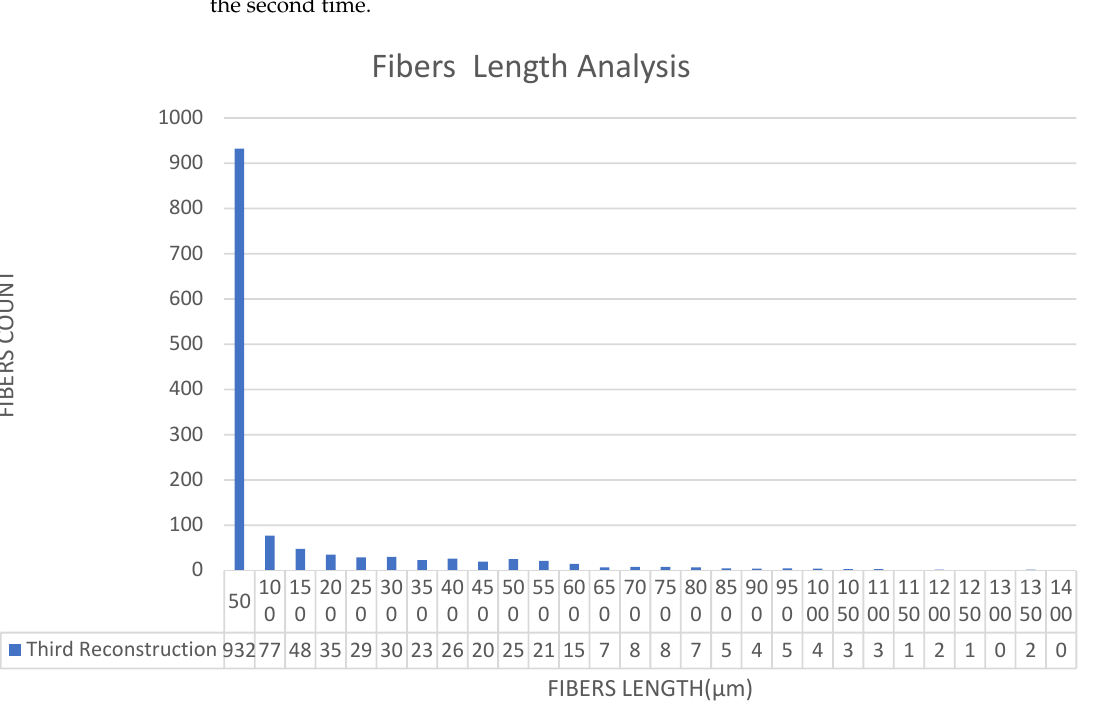
Figure 20. Statistical diagram of the polyester short fiber length reconstructed by Avizo software for the third time.